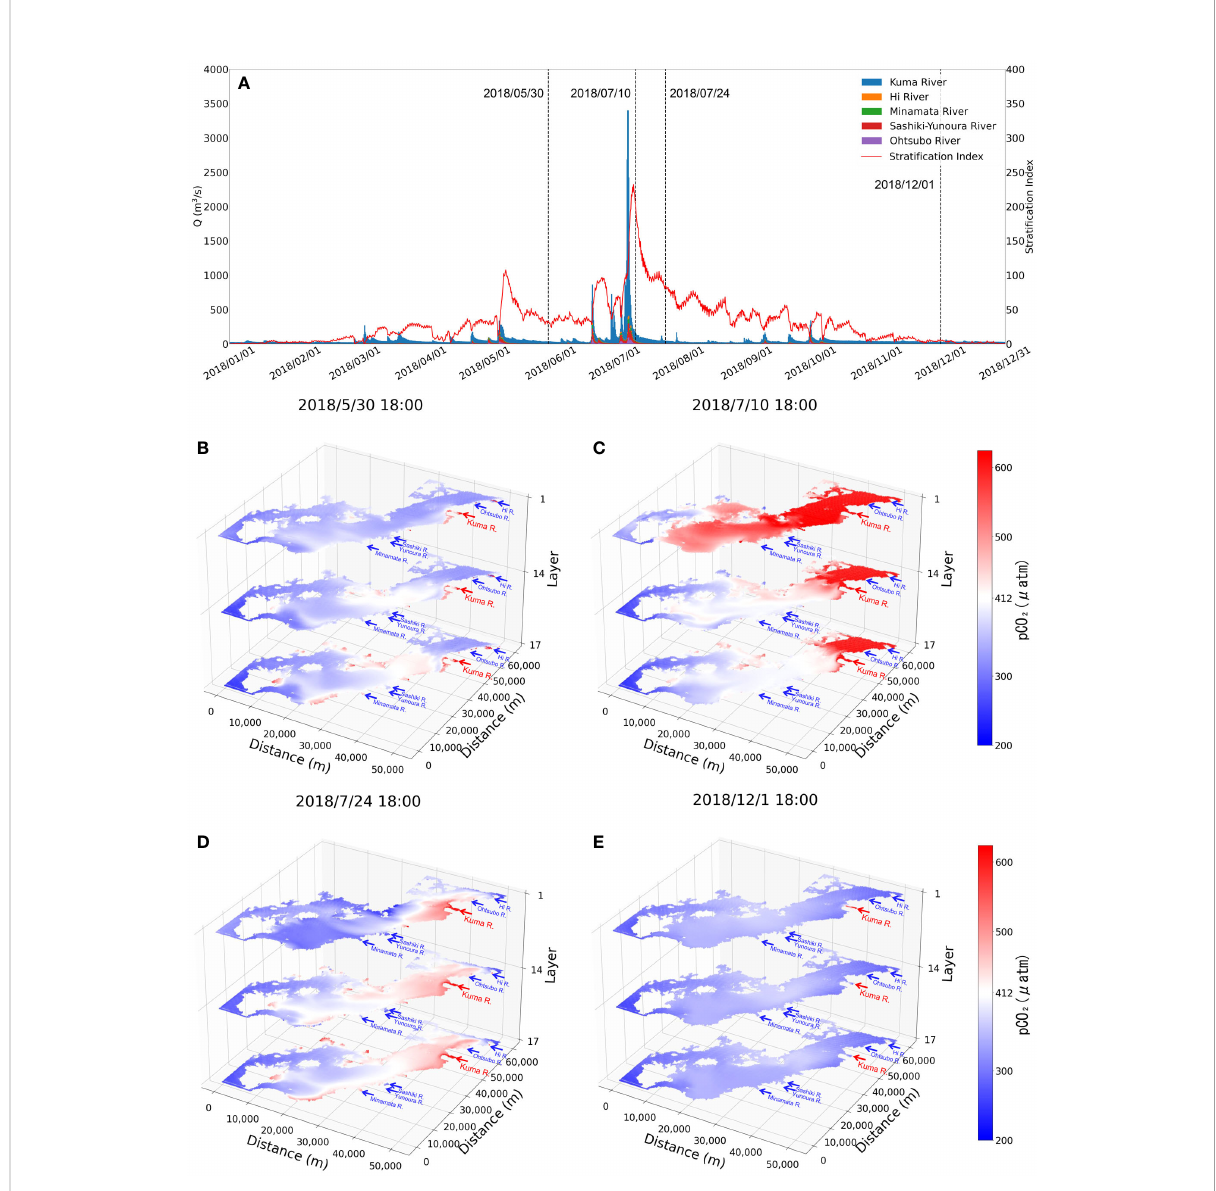
FIGURE 4 Comparison plots of the fl ow rate of the rivers fl owing into the Yatsushiro Sea in 2018 and strati fi cation index (A) and the horizontal distribution of pCO 2 for the four periods (B – E)